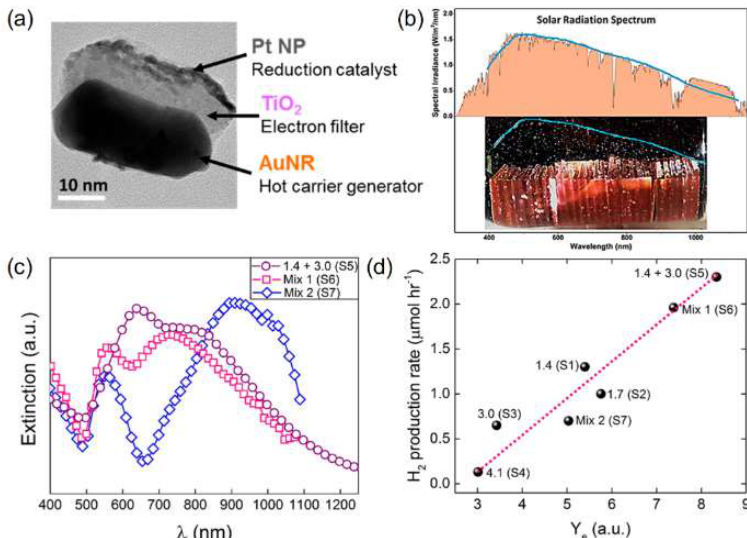
Figure 5. ( a ) Typical morphology of an Au–TiO 2 –Pt nanostructure. ( b ) A digital photograph of hydrogen production. ( c ) Extinction spectra of Au nanorods mixing with different aspect ratios. ( d ) The hydrogen production rates of different catalysts. Copyright 2015 American Chemical Society.